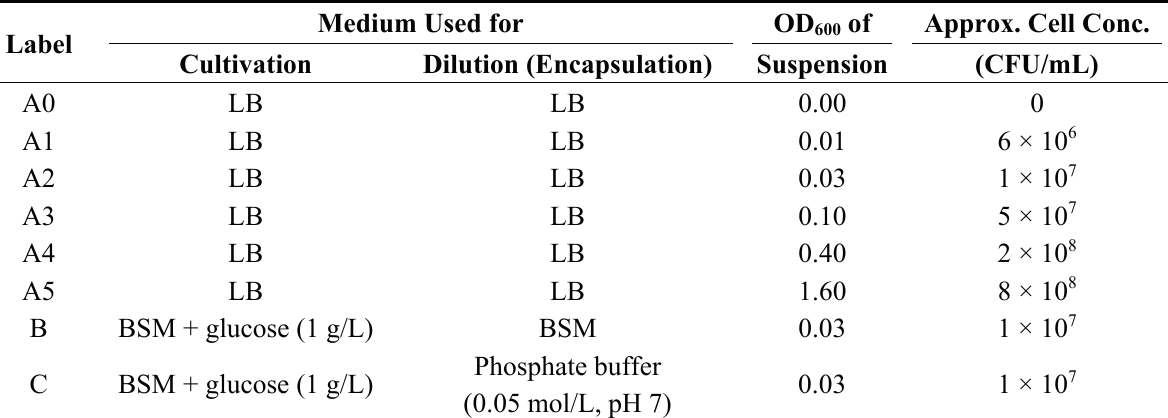
Table 1. Setup of silica gel